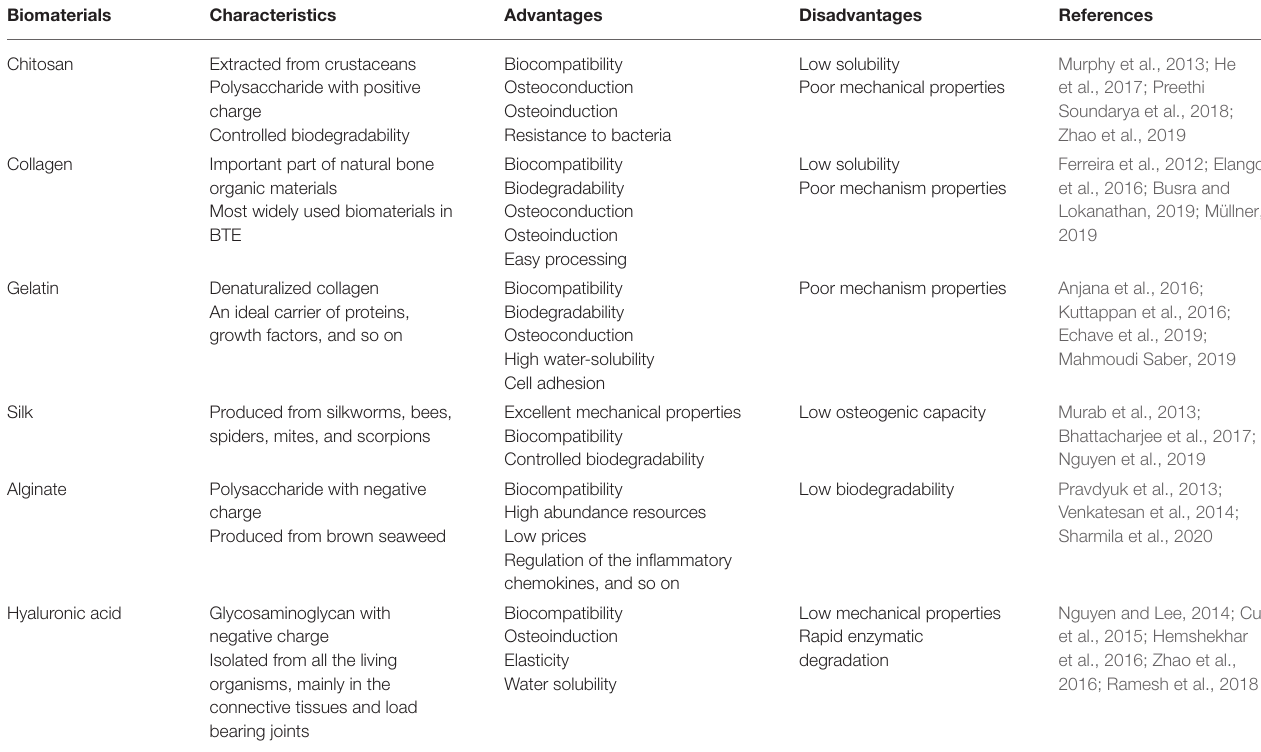
TABLE 2 | Characteristics of various natural polymers used in BTE.